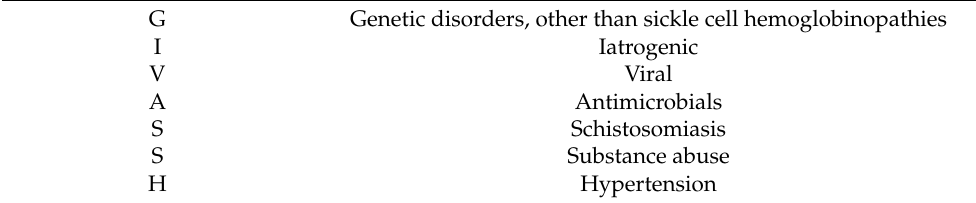
Table 2. Identified factors associated with renal papillary necrosis (RPN) in